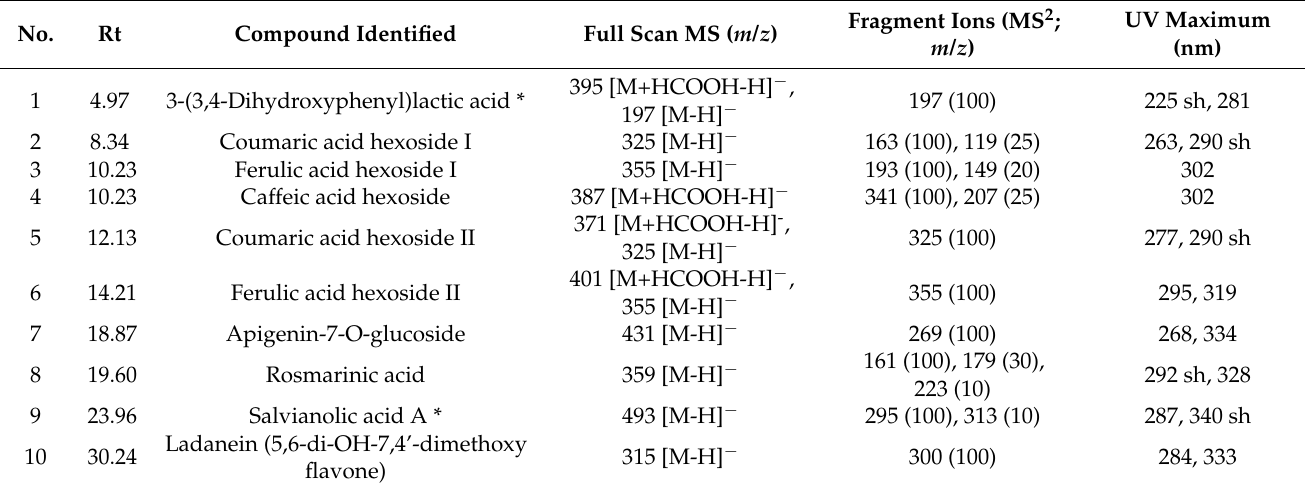
Table 1. Identification of the main common phenolic compounds in the lavandin ethanolic extract (EF) and lavandin